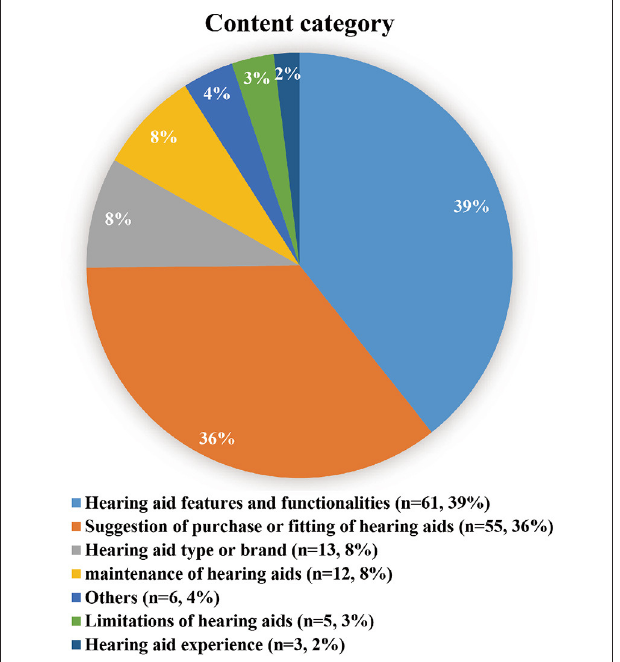
FIGURE 2 | Distribution of video